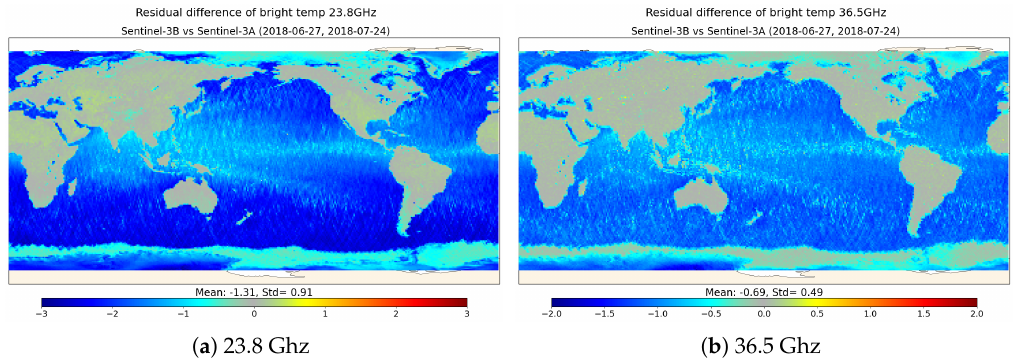
Figure 11. Residual difference between S3A and S3B brightness temperatures before S3B inter-calibration for cycle 10 of